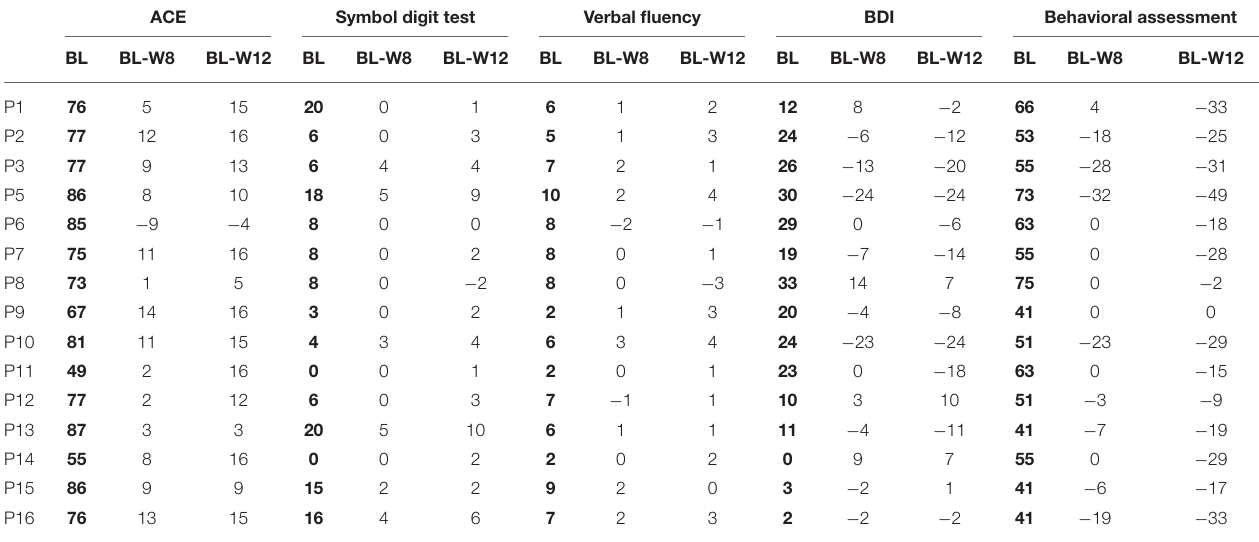
TABLE 2 | Differences during the observation period in cognitive and behavioral dimensions. ACE Symbol digit